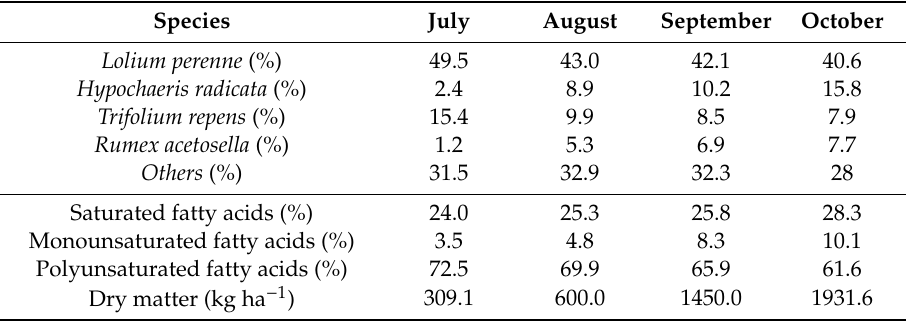
Table 1. Pasture botanical and fatty acid composition in Araucana creole sheep grazing systems in the valley of Araucania